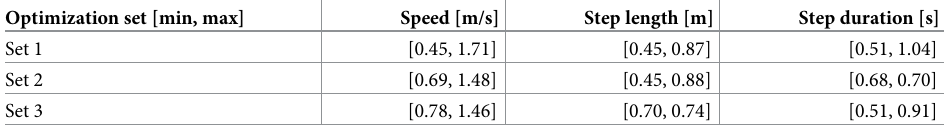
Table 2. Boundaries of the three gait characteristics targeted during the three optimization sets. The first set shows the optimizations’ results where the gait target to reach is the desired speed that varied from the lower to the upper boundary. The second set shows the optimizations’ results with a fixed step duration and a varying target step length. Finally, the third set shows the optimizations’ results with a fixed value of step length, changing the target step